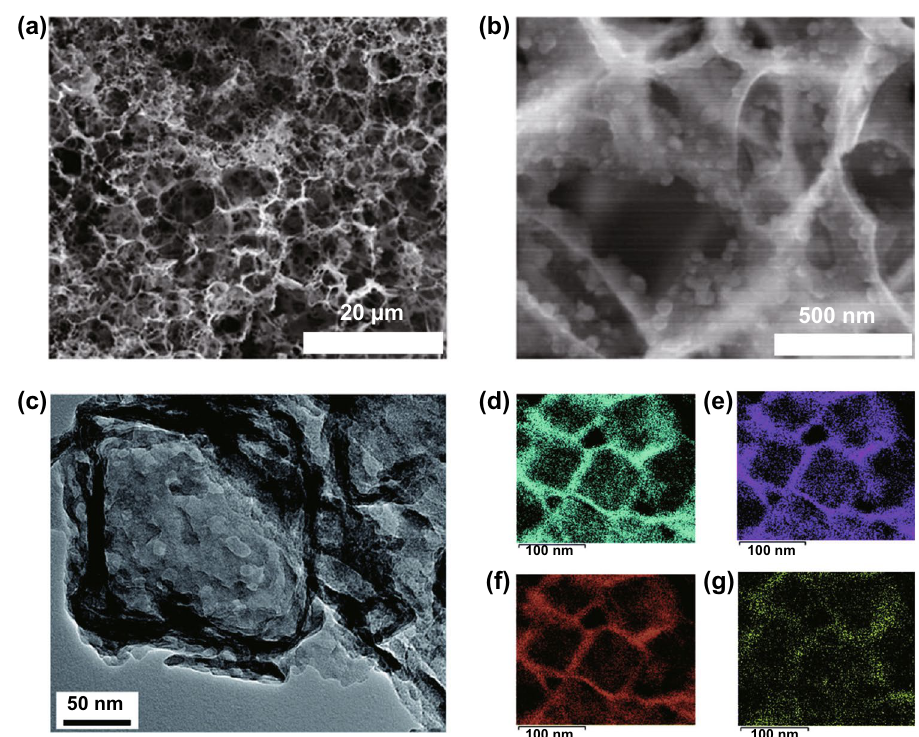
Fig. 13 Scanning electron micrographs of a 3D porous carbon scaffold onto which sulphur nanoparticles are deposited, at a low magnification and b high magnification [180]. Creative Commons License (CC BY 4.0). c Transmission electron micrograph of a polysulphide-adsorbing TiO 2 -MnO nanobox cathode infiltrated with sulphur, and associated energy-dispersive X-ray spectroscopy maps for d Ti, e Mn, f O and g S [181] . Copyright 2021, Royal Society of